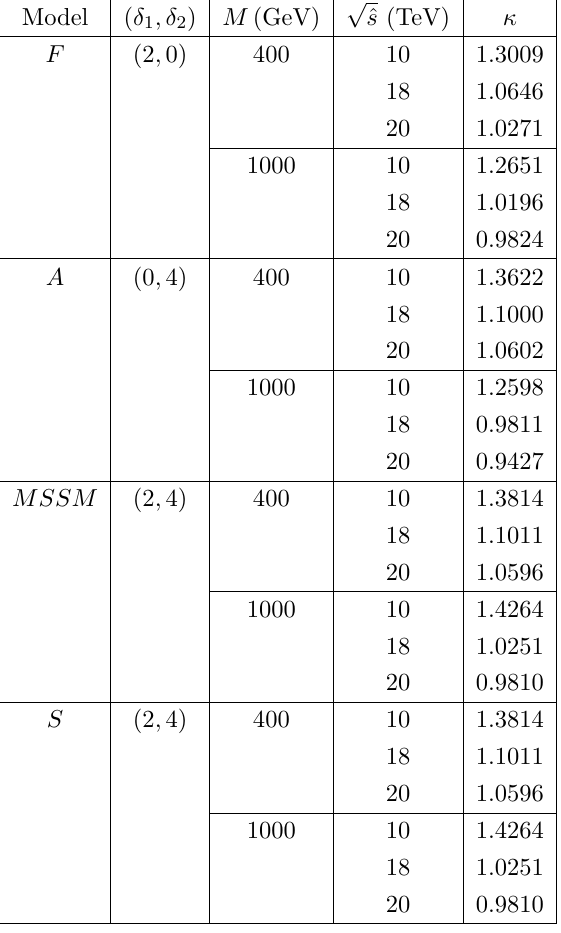
Table 2. Values of (cid:20) , characterizing the deviation of the enhancement due to gauge boson emission from its SM value. k = 1 is compatible with the following modi(cid:12)cation of the holy grail function: p p F [ ^ s ] ! F [ ^ s (cid:0) (cid:14) (cid:1) M